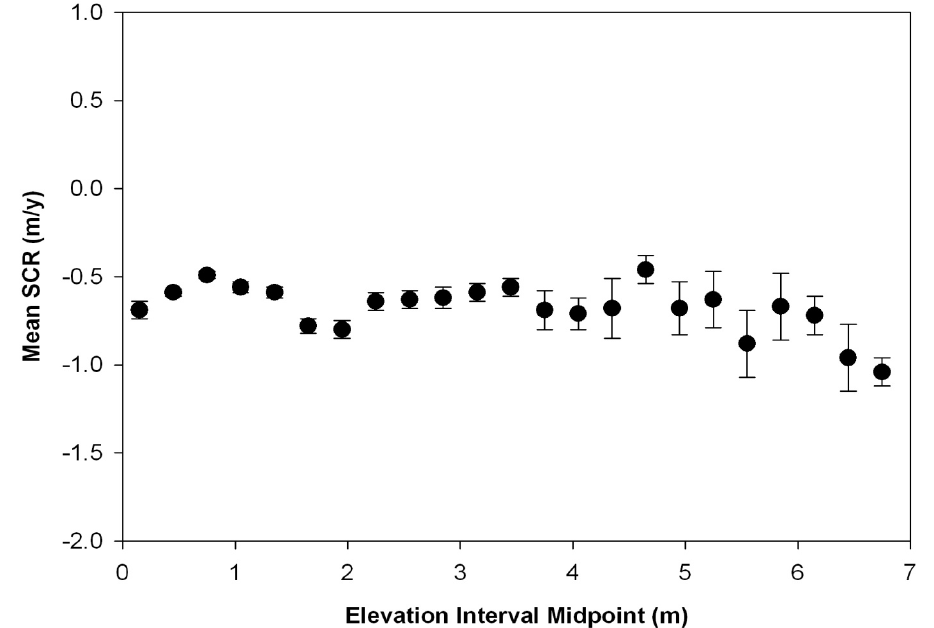
Figure 3. Plot of mean shoreline-change rate (±1 standard error) for the binned 30 cm elevation